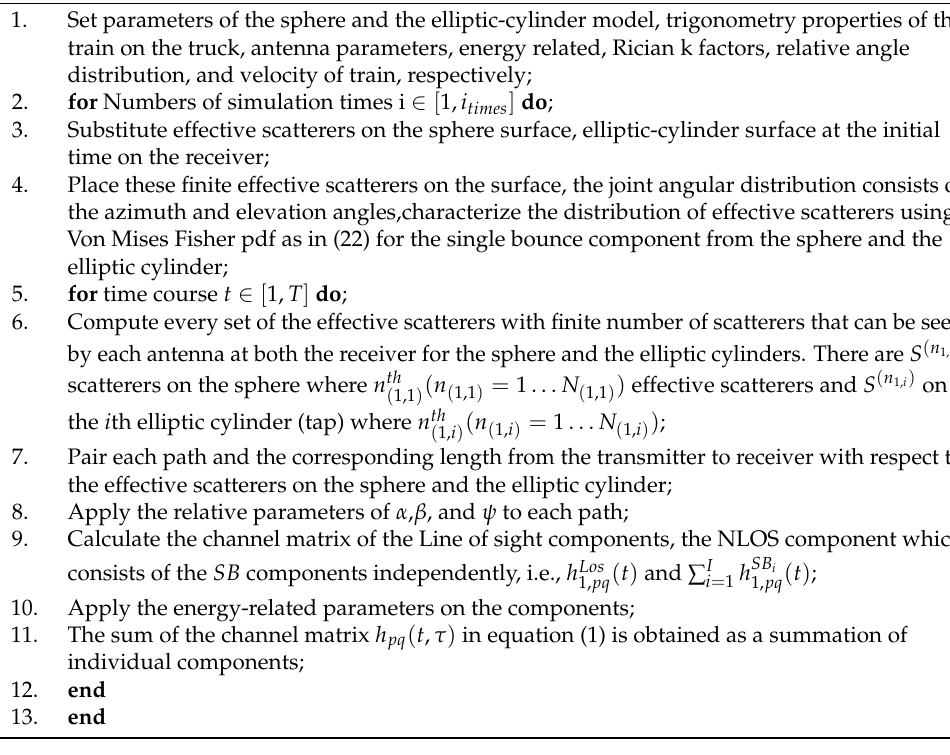
Algorithm 1 Channel Simulation